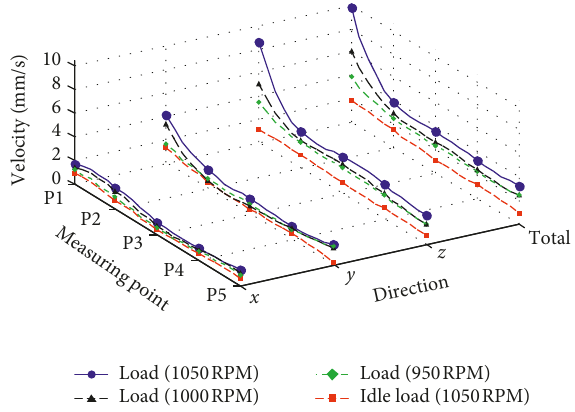
Figure 3: Comparison of velocity of P1–P5 when No.1 compressor ran